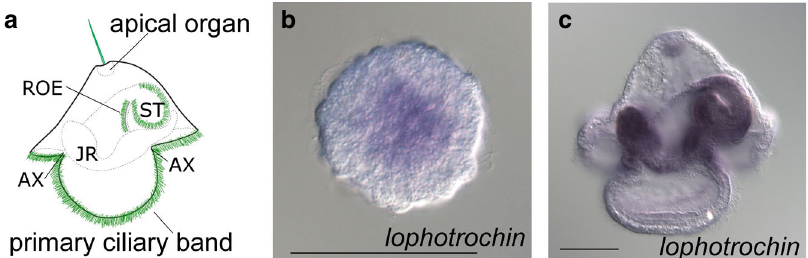
Fig. 4 Lophotrochin and trochin expression in the nemertean Maculaura alaskensis . a Diagram of a torus-stage pilidium larva, cilia in green. Only one complement of the paired structures is shown for clarity (i.e., left lappet, left ciliary ridge, and left anterior and posterior axil). AX: axil, JR: juvenile rudiment, ROE: ciliated ridge of esophagus, ST: stomach. b The fi rst expression of lophotrochin (purple) is noted at gastrula stage — in the developing archenteron, but not in ectodermal ciliated cells. c In later developmental stages, more structures with lophotrochin expression are found: stomach, ciliated ridges of esophagus, juvenile rudiment, the axils — recesses between lobes and lappets, the apical organ, and the primary ciliated band adjacent to the axils. Scale bars: 50 μ m. For each in situ hybridization, at least 20 animals were stained and all had the pattern shown.